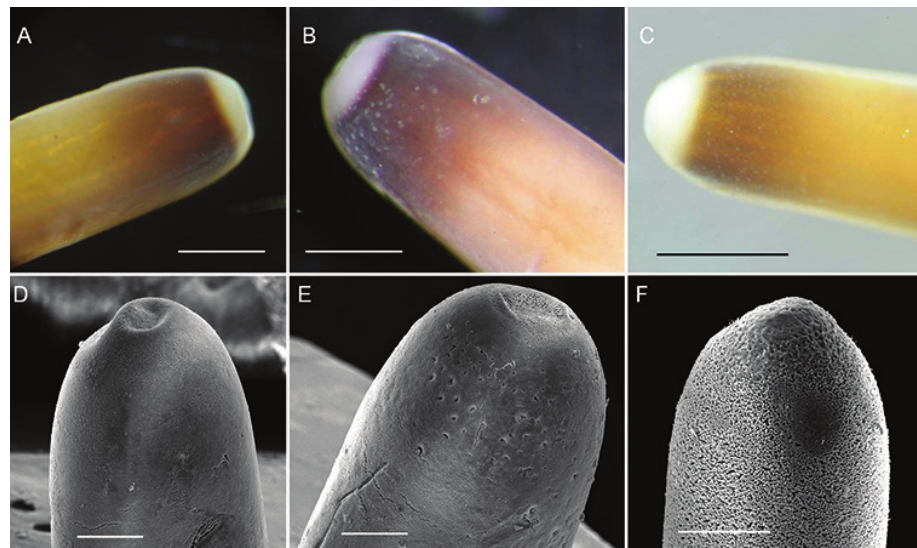
Figure 1. Anterior end of Acutogordius taiwanensis sp. n. A–C Images of the anterior end showing the ( A ) white cap and dark-brown collar and B–C white spots scattered on the brown collar D–F SEM im- ages of the anterior end surface that is D smooth E smooth but wrinkled on the tip with holes scattered on the dark-brown collar, and F wrinkled A–F are images from the same individual, respectively. Scale bars 500 µm ( A–C ), and 200 µm ( D–F